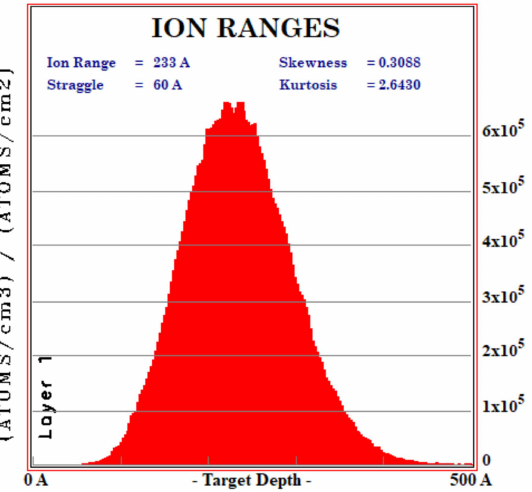
Figure 4. Simulation of distribution of stopping range of implanted 181 Hf isotope in rutile TiO 2 using SRIM 2013. We assume that rutile TiO 2 has a density of 4.25 g/cm 3